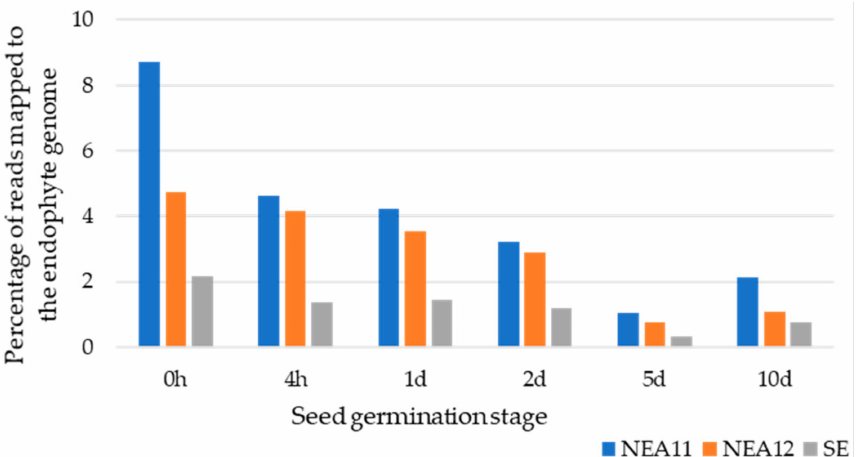
Figure 2. Percentages of total number of reads mapped to endophyte reference genomes for SE, NEA11, and NEA12 at different time points of seed germination during early stages of symbiotum